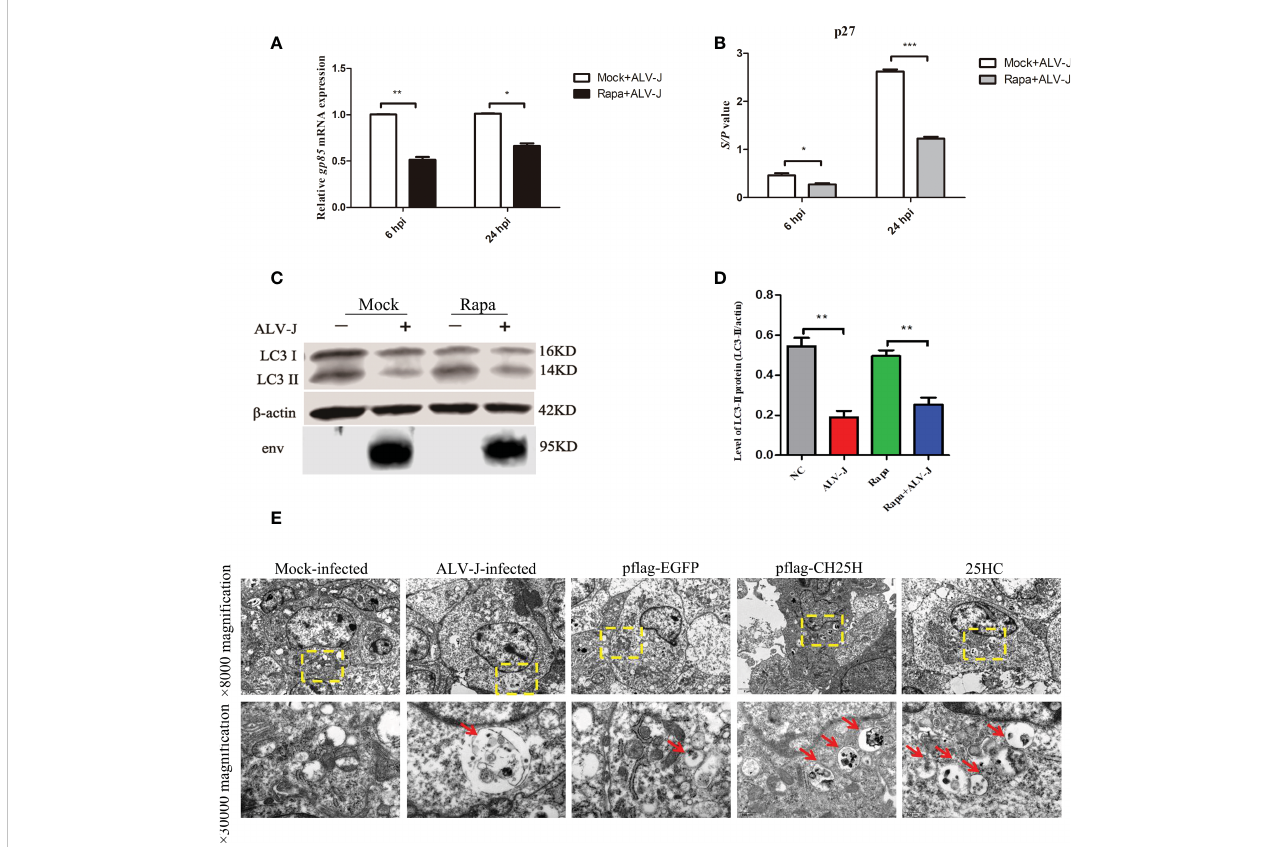
FIGURE 4 CH25H inhibits ALV-J by promoting autophagy. (A) DF-1 cells were pretreated with Rapa for 12 h and then infected with ALV-J (10 5 TCID 50 /0.1mL) for 6 h and 24 h, respectively. The gp85 mRNA levels were detected by qRT-PCR for the indicated time. (B) The ALV-J p27 protein was measured by ELISA for the indicated time. (C) DF-1 cells were pretreated with 1 m M Rapa for 2 h and then infected with ALV-J (10 5 TCID 50 /0.1mL) for 24 h. Expression levels of LC3II were analyzed using immunoblot. (D) The quanti fi cation of LC3II/ b -actin was analyzed by Image Studio software. (E) Autophagosomes were observed with TEM. CH25H transfected and 25HC treatment cells showed autophagosomes, and few autophagic vacuoles were observed for ALV-J infected and controlled vector-transfected cells. The red arrow indicates an autophagosome. The top row pictures are ×8000 magni fi cation. The bottom row pictures are ×30000 magni fi ed from the yellow box of the top row. hpi represents hours post infection. Data shown are the means ± SEM of at least two independent experiments. P values were calculated using unpaired Student ’ t -test. A P -values < 0.05 were considered statistically signi fi cant differences, and a P -values < 0.01 were considered highly statistically signi fi cant differences. * P < 0.05, ** P < 0.01, *** P <